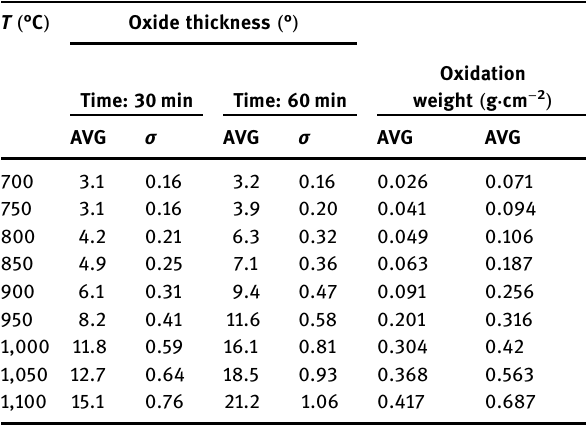
Figure 5: Oxide - scale thickness of